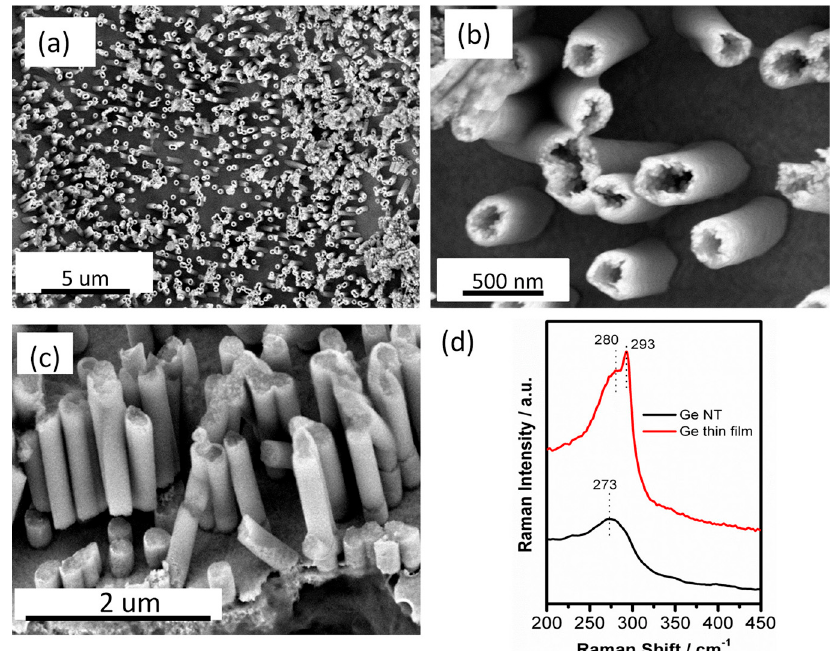
Figure 12. ( a ): Low magnification image of free-standing Ge nanotubes after removal of the template. ( b ) Higher magnification image of the Ge nanotubes. ( c ) Cross sectional view of the Ge nanotubes. ( d ) Raman spectra of electrodeposited Ge thin films and nanotubes obtained by exposing the sample to 5 mW, 532 nm laser for 10 s. Reprinted with permission from Lahiri et al. [201].